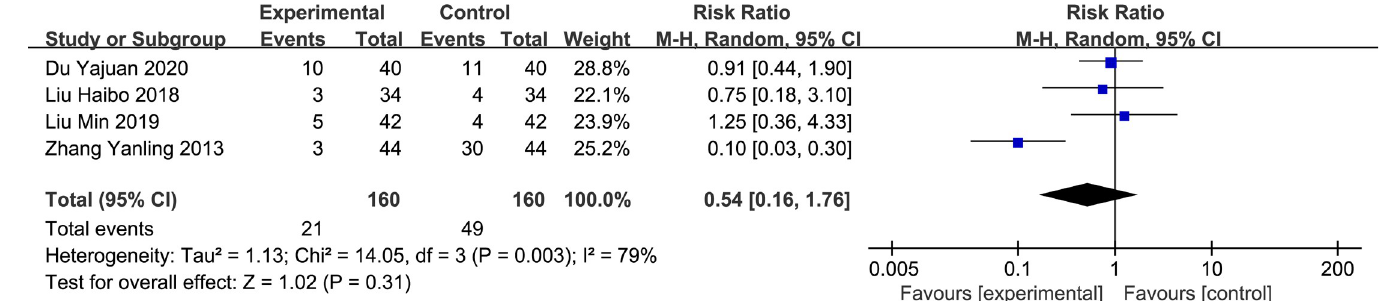
Fig 9. Forest plot of the incidence of dizziness between experimental and control group.